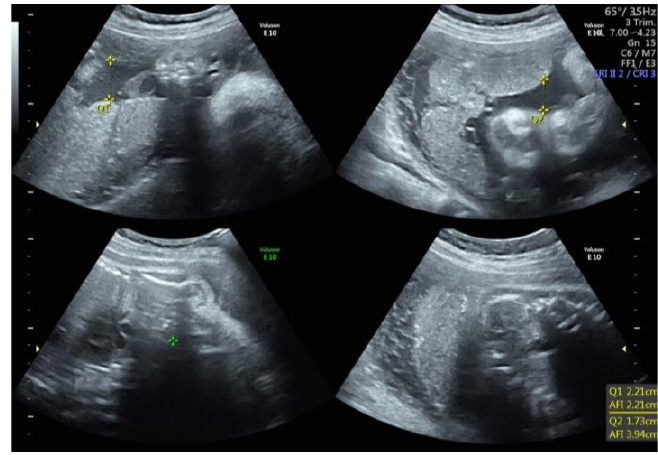
Figure 1. Oligohydramnios. Q: quadrant. AFI: Amniotic Fluid Index